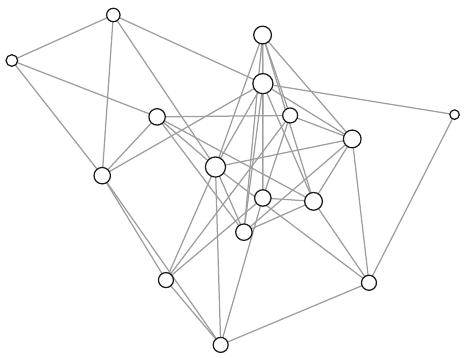
Figure 1: Complete network of size 16 nodes.